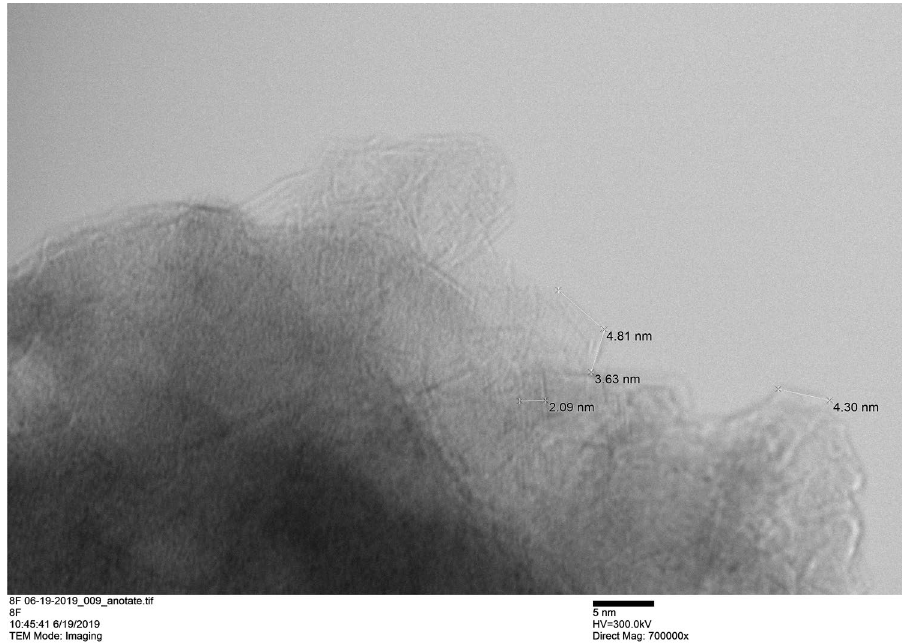
Figure 8. TEM image of an aggregate of pseudoboehmite nanoparticles.